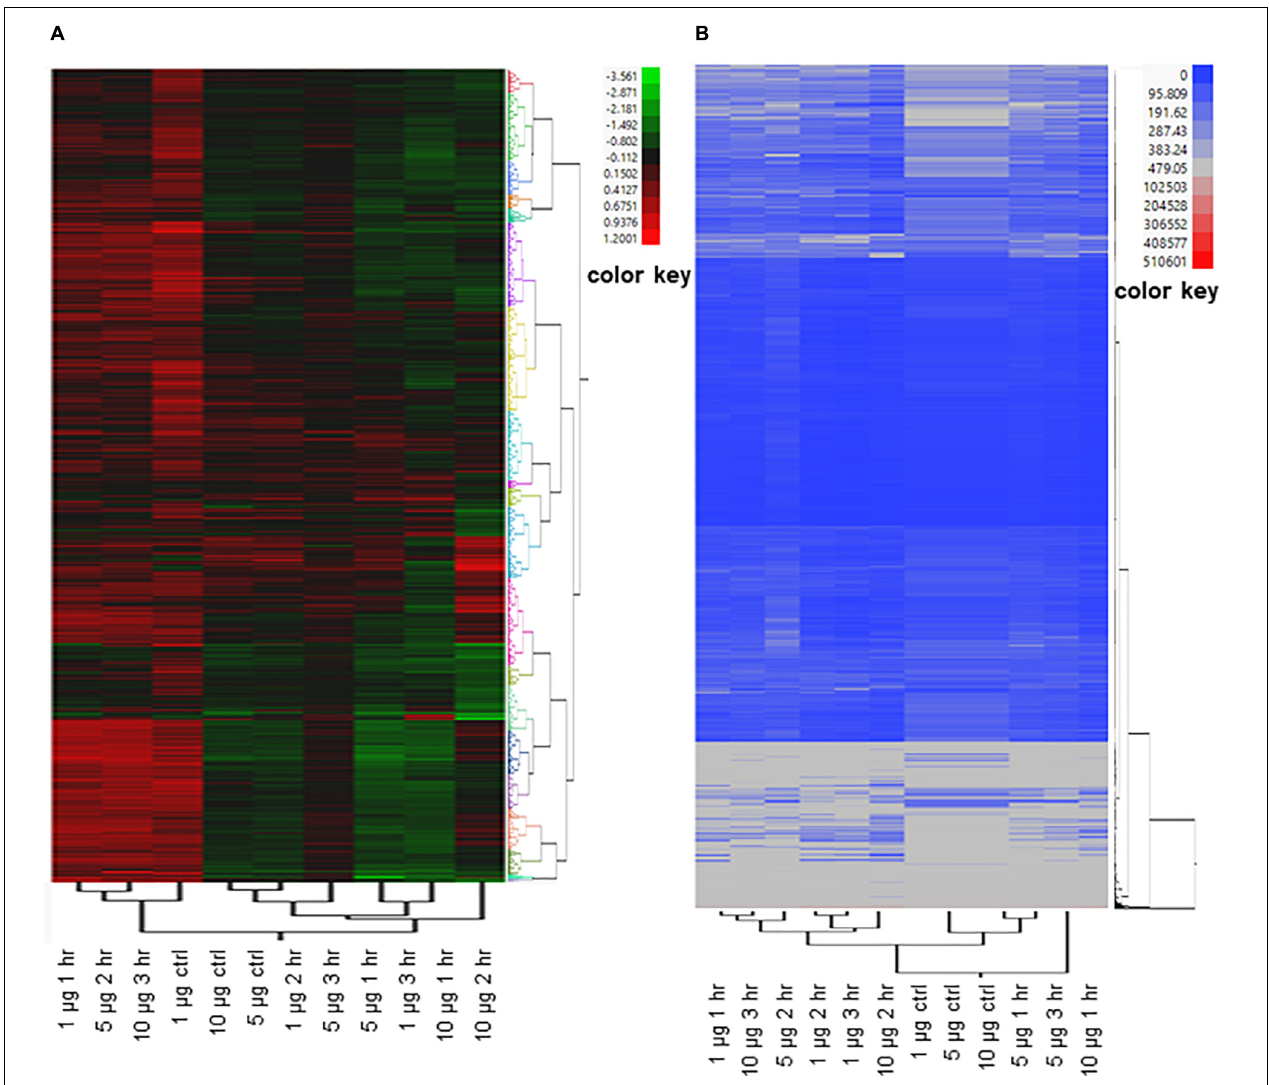
FIGURE 4 | Two-way clustering of differentially expressed E. coli genes. Ward’s Hierarchical Clustering was performed to analyze propensity transformation (PT) values (A) and RPKM values (B) of E. coli genes in response to 1 µ g, 5 µ g, and 10 µ g of ClO 2 treatments after 1 h, 2 h, and 3 h. The number of clusters was set at 20 shown in Additional file 2 : Supplementary Table S2 , and clusters were color coded. Red indicates high expression and green (A)/blue (B) indicate low expression.